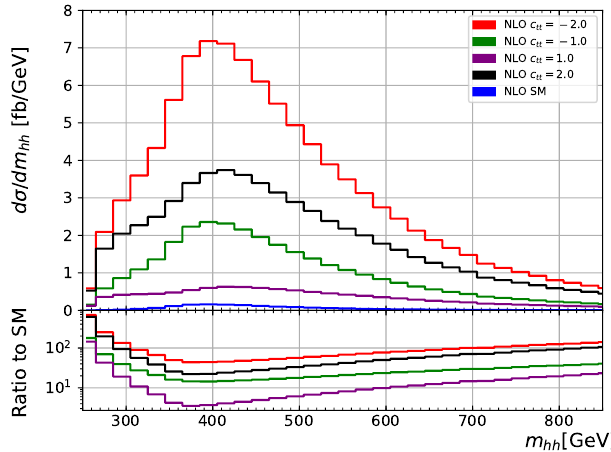
Figure 26. Higgs boson pair invariant mass distributions for various values of c tt